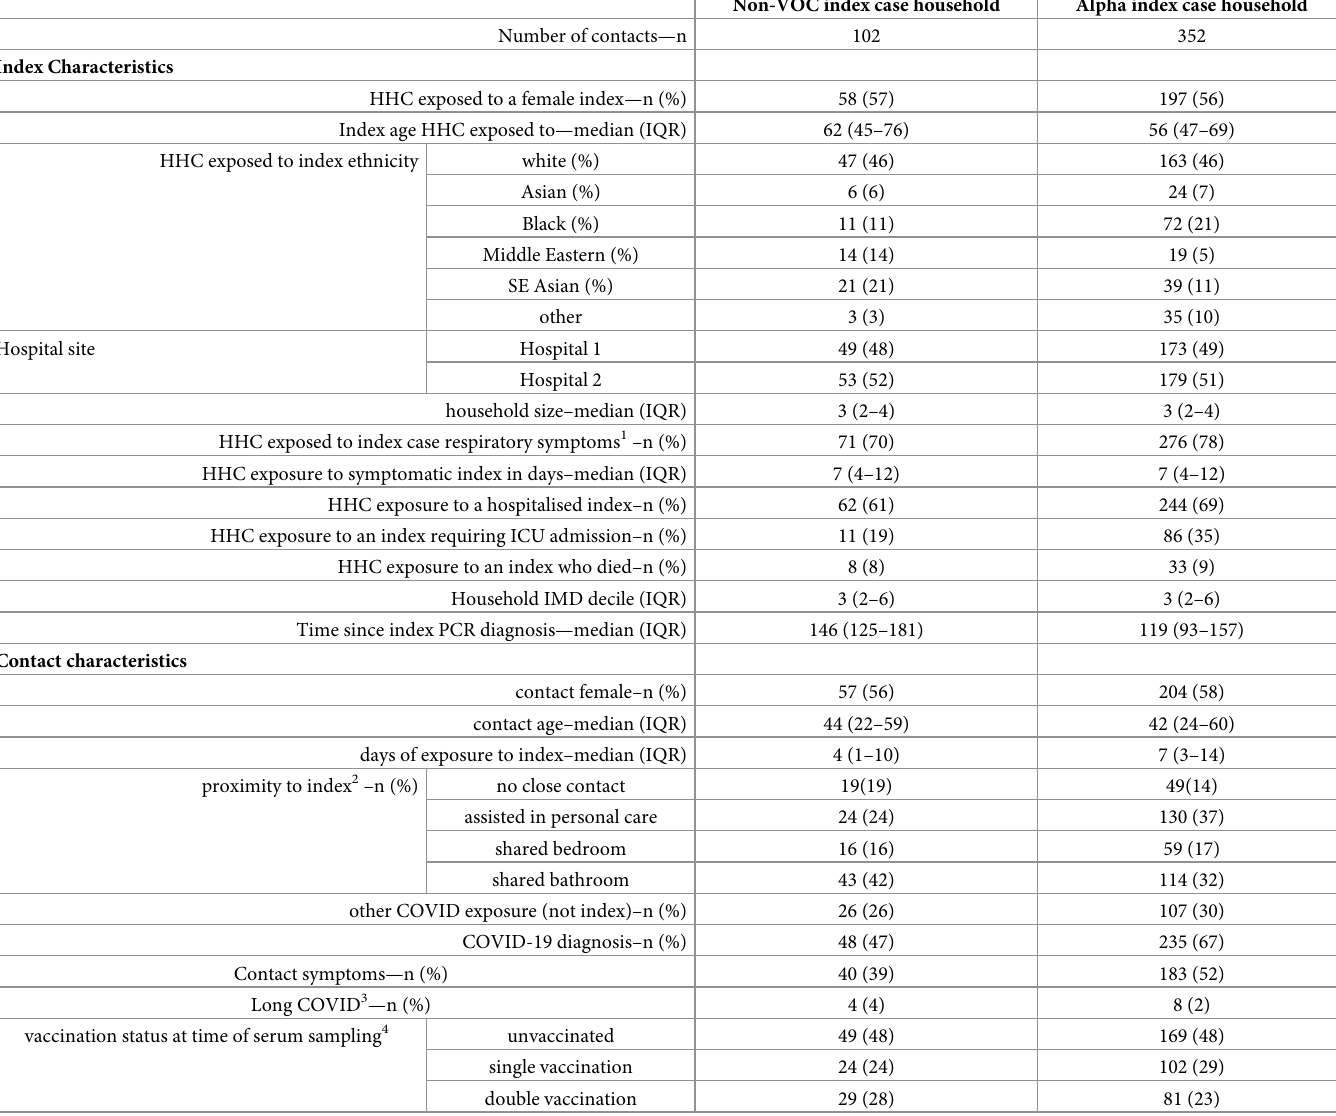
Table 2. Baseline characteristics of 454 household contacts stratified by index case Alpha or non-VOC SARS-CoV-2